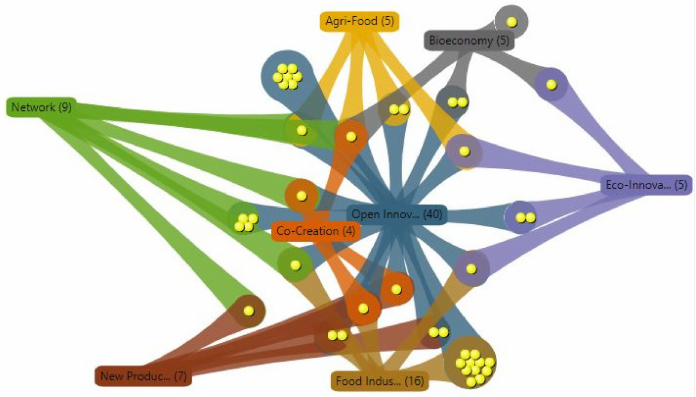
Figure 6. Cluster of relationships between the top 8